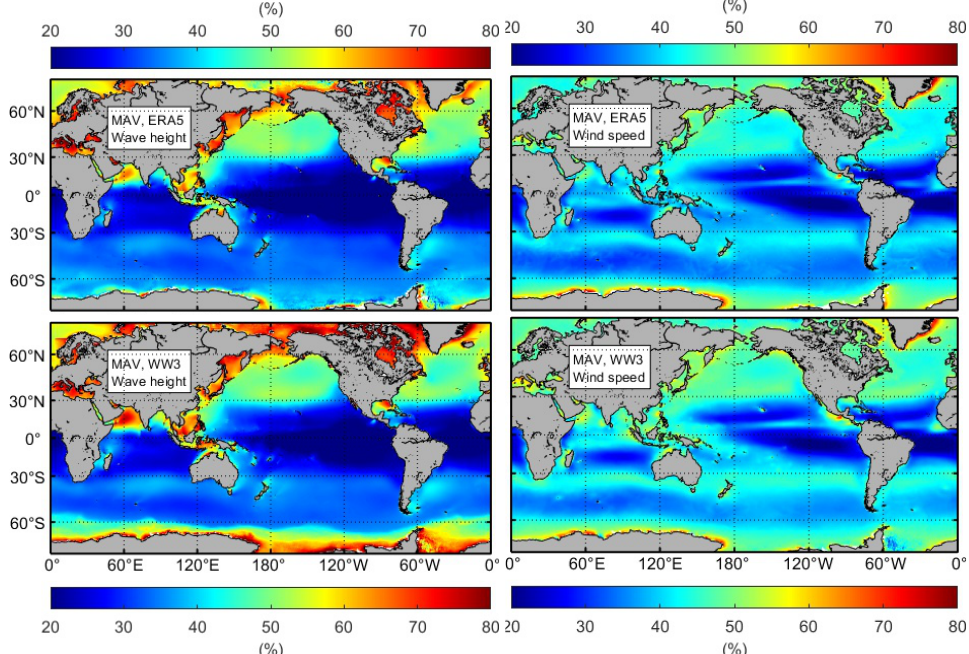
Figure 3. Mean annual variability (in %) ( top : ERA5, bottom : WW3, left : significant wave height, right : wind